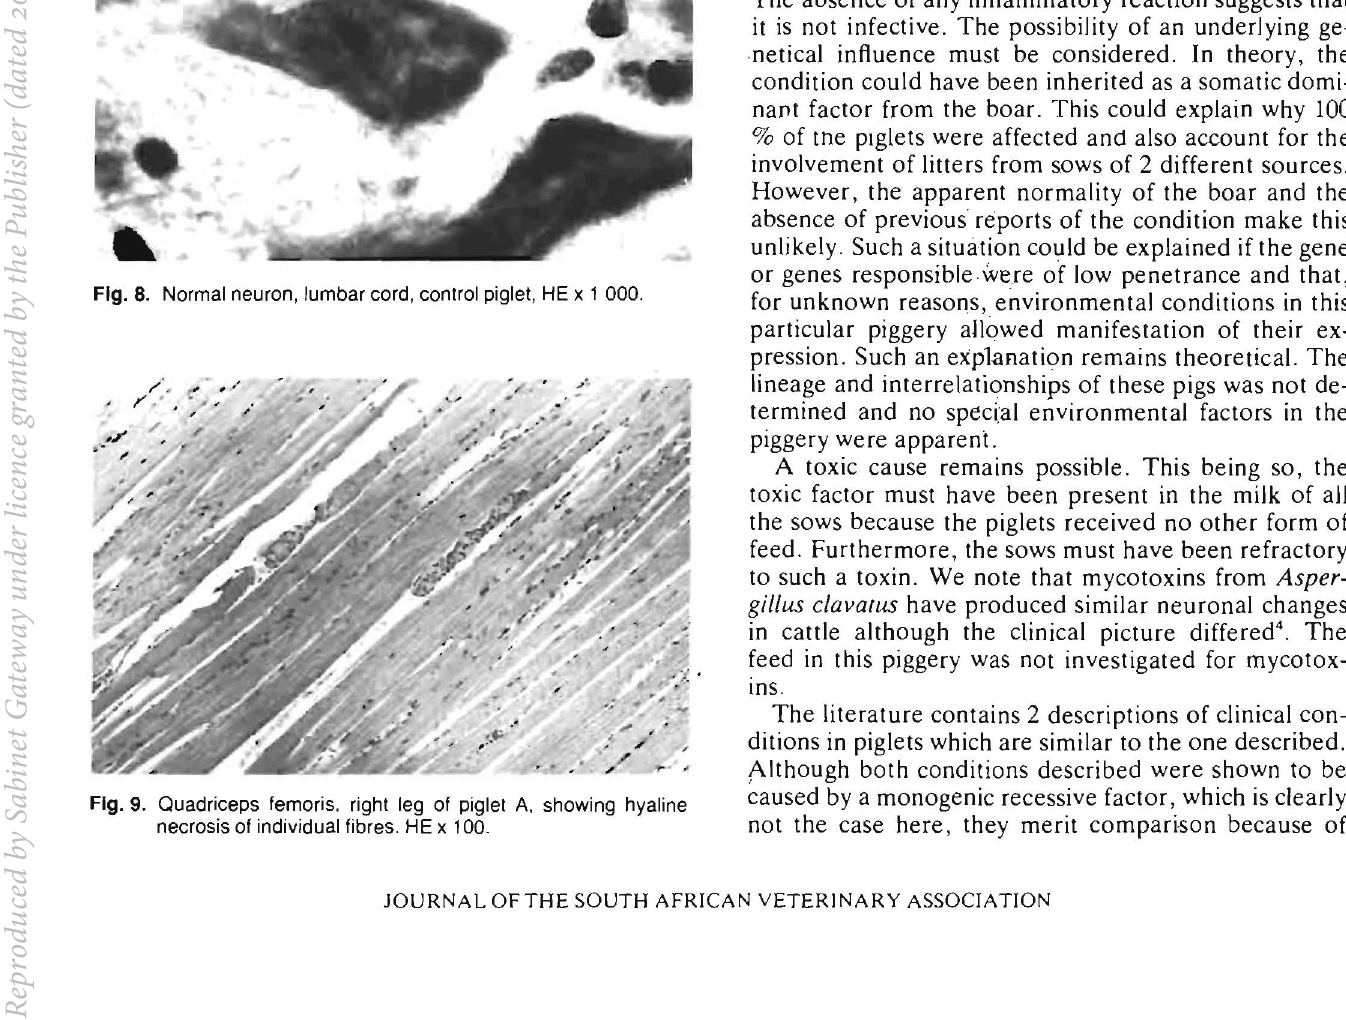
Fig. 8. Normal neuron, lumbar cord, control piglet, HE x 1 000.